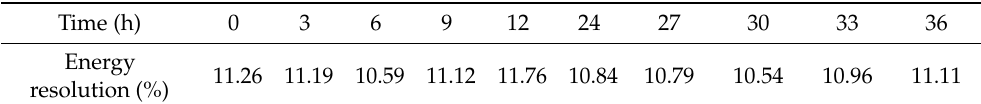
Table 1. The energy resolution of the CsI(Na) Φ 25 mm × 50 mm crystal with different